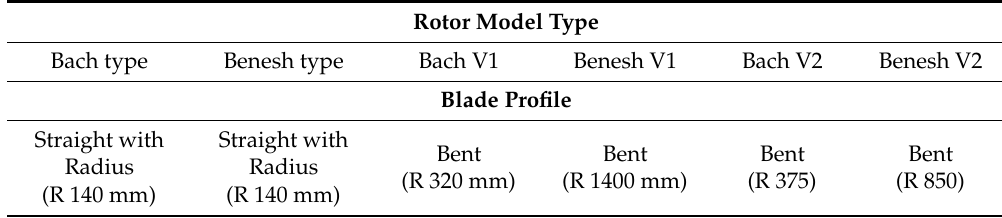
Table 4. Main rotor typologies considered for numerical analysis.